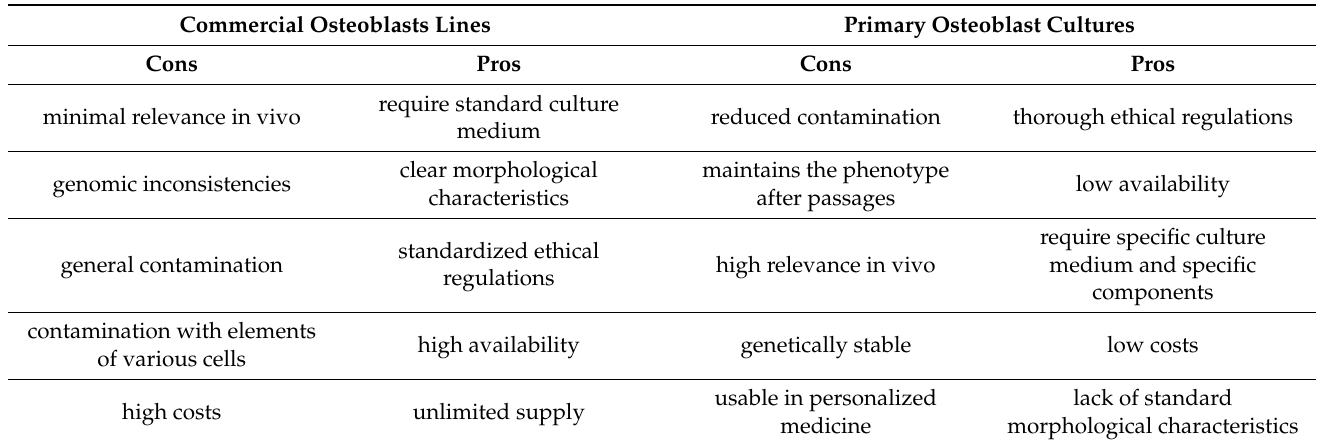
Table 1. The main common types of cells sources used for biocompatibility testing. Differences and